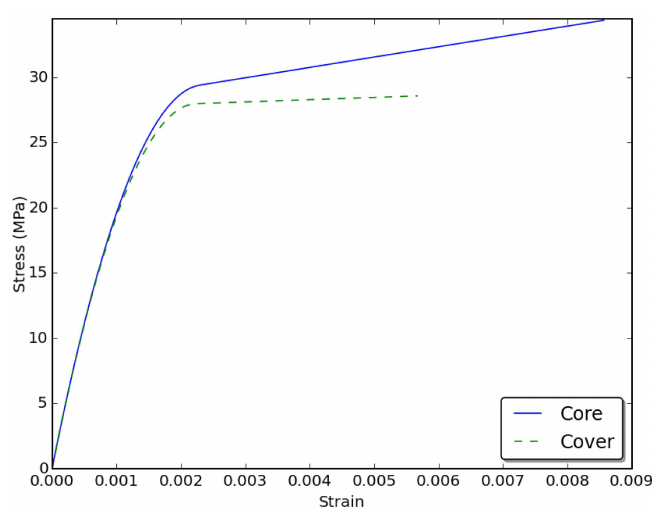
Figure 19. Stress-strain curve for Sample 1, s = 25.4 mm.